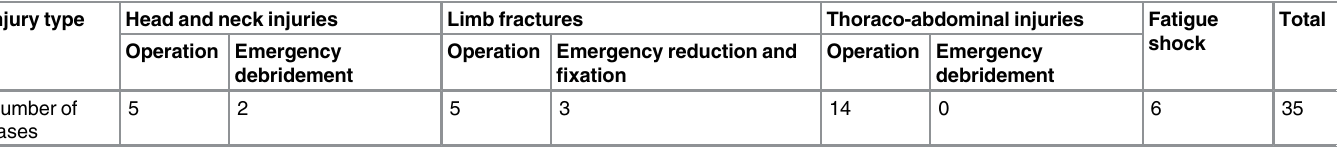
Table 1. Injury classification of 35 medical relief records.